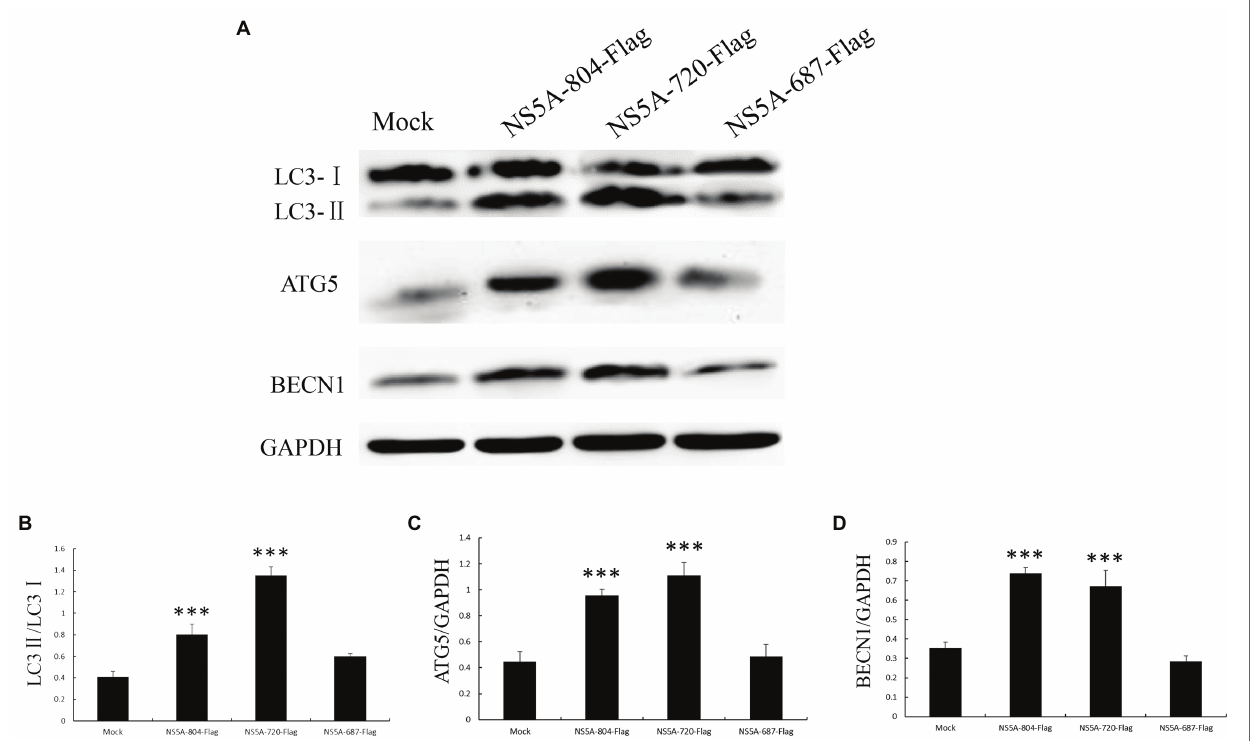
FIGURE 6 | Expression of autophagy marker proteins in cells expressing different portions of the NS5A gene. (A) PK-15 cells were transfected with sequences expressing different portions of the NS5A gene or a mock plasmid. The expression of LC3, ATG5, BECN1, and GAPDH (loading control) was analyzed by immunoblotting with specific antibodies described in the Materials and Methods. The data represent the mean ± SD of three independent experiments. Statistical comparisons were evaluated using ANOVA followed by Tukey’s HSD post hoc analysis. *** p < 0.001, compared with the mock